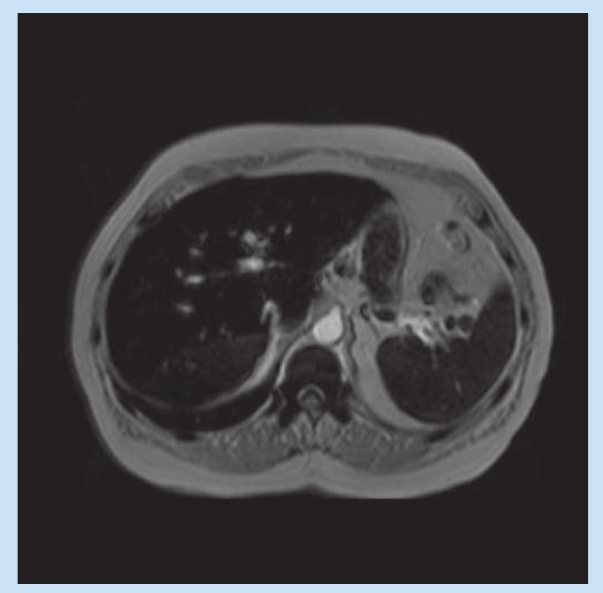
Fig. 1b. Axial T2W image demonstrating T2 shortening in the liver and